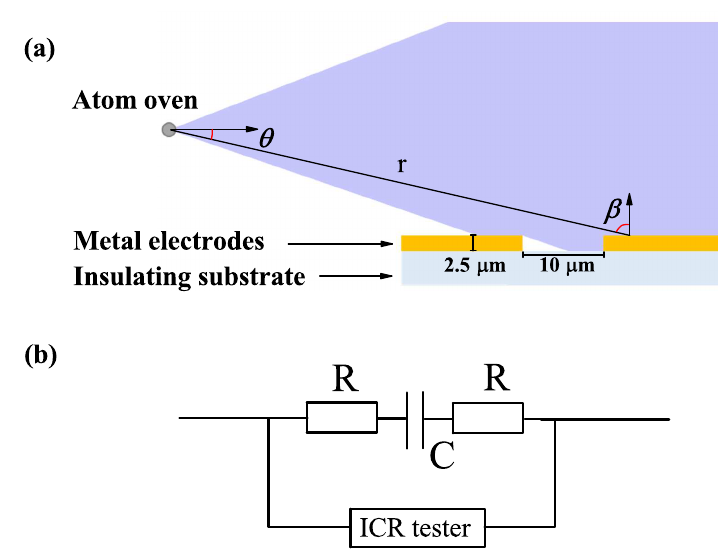
Figure 1. (Color online) ( a ) Cut through the atomic beam with solid angle sweeps across the surface ion trap. Atoms leaving the oven through an angle θ are spread over the trap surface with distance r and normal angle β . ( b ) Circuit diagram of the surface ion trap. The electrode gap is an equivalent capacitance, C , and the electrode is an equivalent resistance, R .